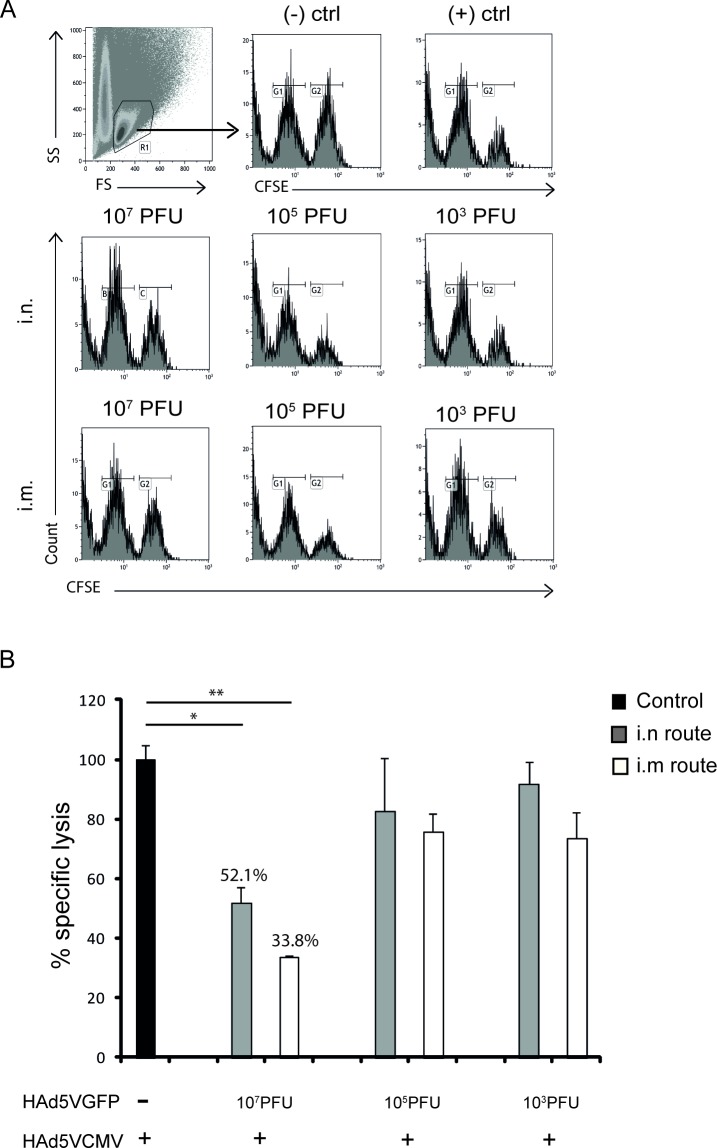

In vivo cytotoxicity levels against the murine CMV CD8 T-cell epitope YPHFMPTNL detected in animals with pre-existing HAd5V immunity or control animals after immunization with different doses of HAd5V-based vaccine vector, HAd5VCMV.Mice were immunized by either i.n. or i.m. routes with different doses of HAd5VGFP as indicated (103, 105 or 107 pfu/animal). Four weeks later, mice were vaccinated with one (prime) dose of 1×109 pfu/animal of HAd5VCMV administered subcutaneously. The lowCFSE and highCFSE+CMVCD8-peptide labeled cells were identified by flow cytometry using the gates shown in panel (A). Histograms show data from a single mouse. FS–forward scatter, SS–side scatter. (B) Percentage of specific lysis induced in vaccinated animals after a single immunization (prime). The specific lysis was normalized to the positive control (set as 100% of specific lysis). Negative control represents mice that were not immunized with any adenovirus vector. The graph in panel (B) shows one of three independent experiments with at least 3 mice per group. Bars represent mean values +/- SD. (+) ctrl–positive control, (-) ctrl–negative control; (-) mice non-immunized with adenovirus; i.n.–intranasal immunization route; i.m.–intramuscular immunization route.